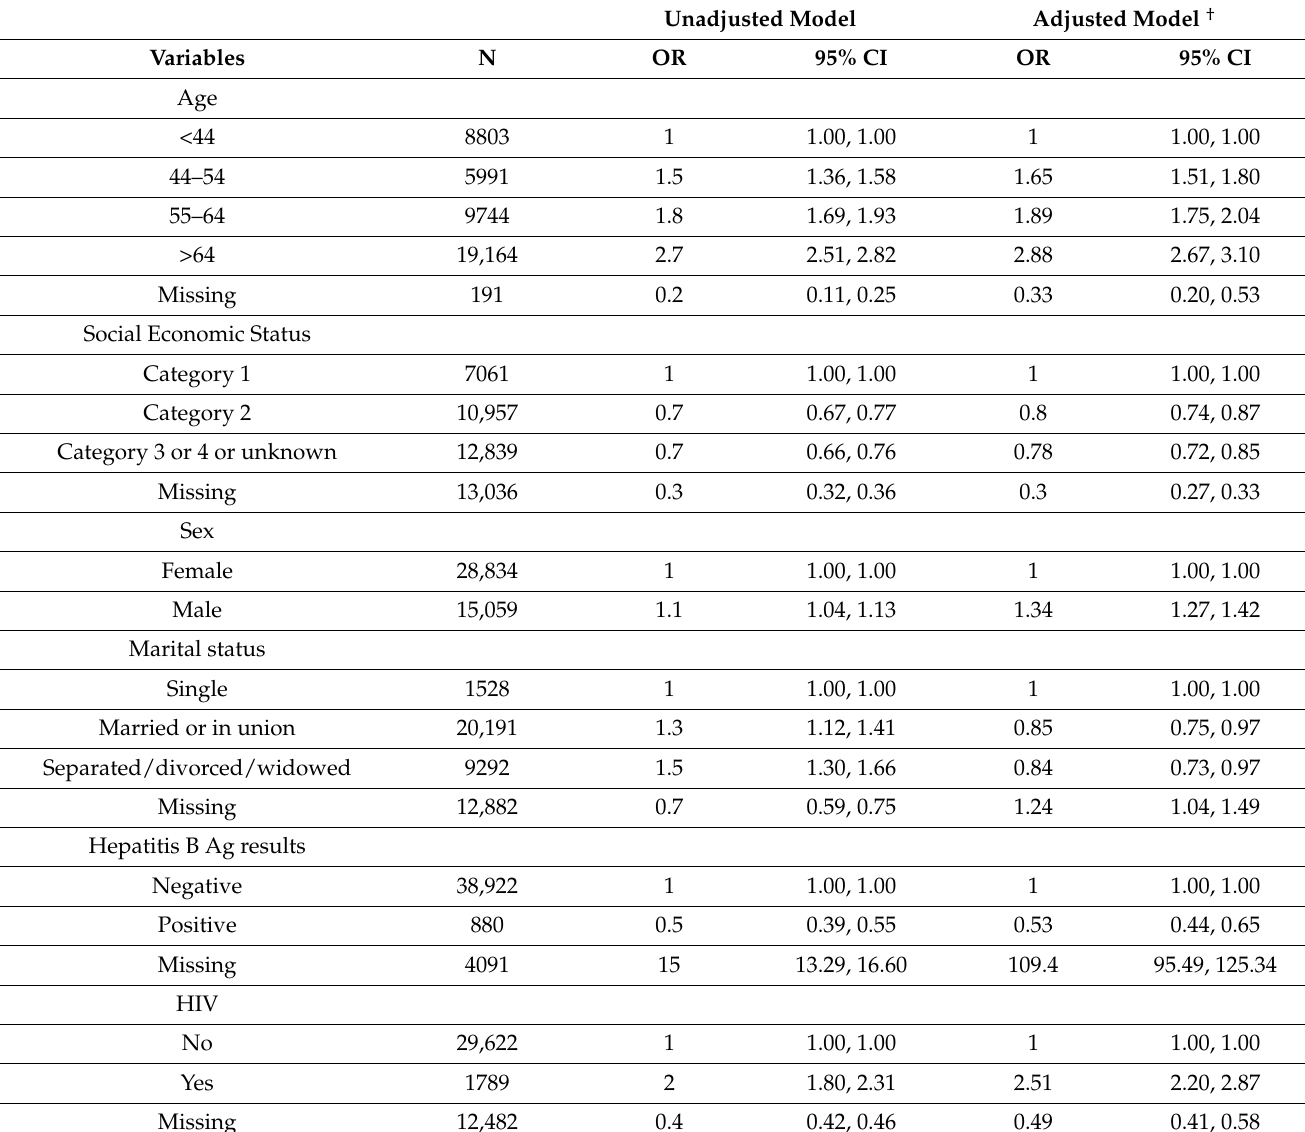
Table 4. Unadjusted and adjusted associations between HCV RNA positivity and socio-economic, demographic, clinical, behavioral, and hospital characteristics